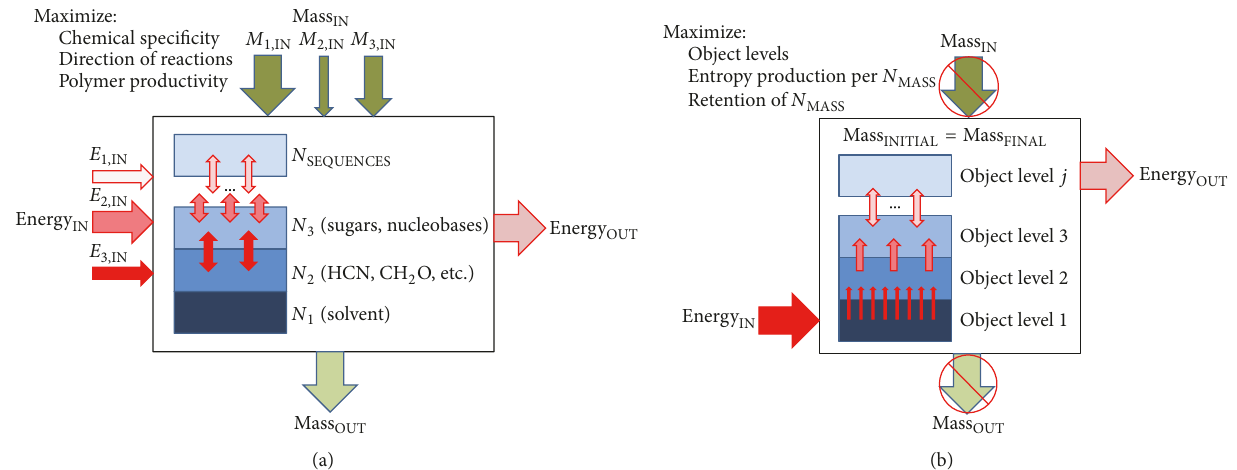
Figure 2: (a) Mass-energy scheme of typical prebiotic experiment architecture. (b) Mass-energy scheme of subsumed complexity experiment